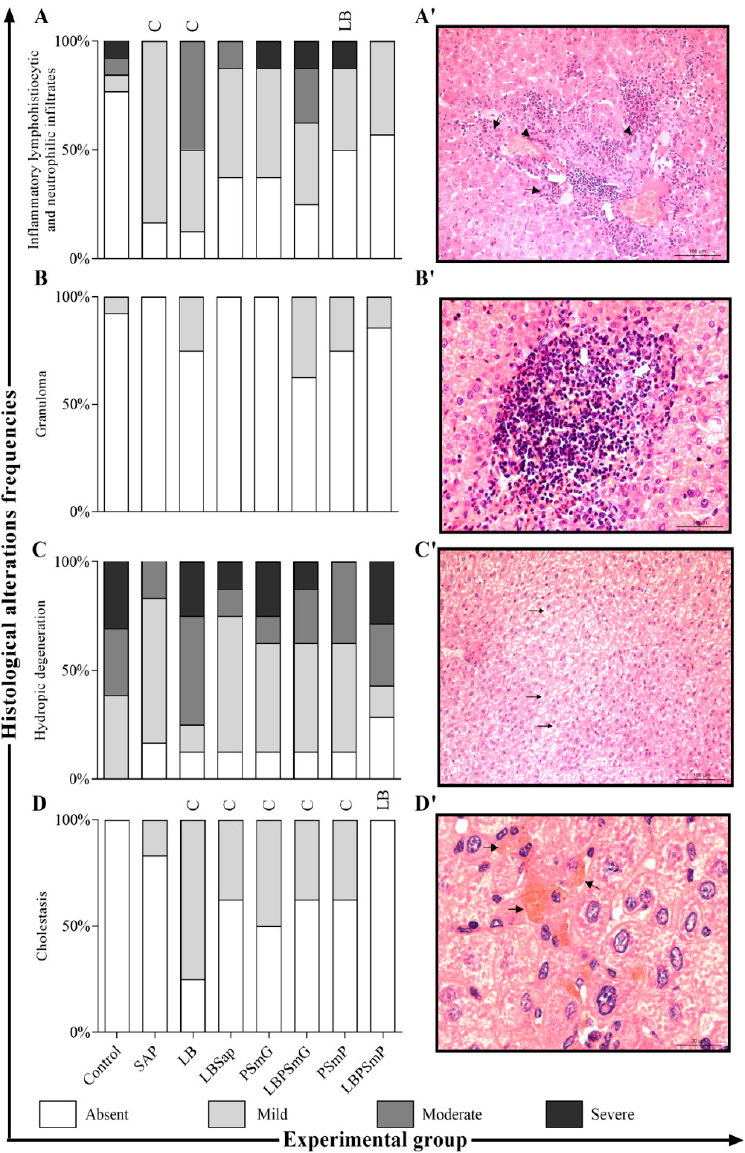
Figure 2. Histological changes in the liver after experimental L. infantum challenge in slides stained by Hematoxylin and Eosin. On the left: The x axis represents the frequency of each histological change ( A – D ) according to the immunization group (Control—C, Sap, LB, LBSap, PSmG, LBPSmG, PSmP, and LBPSmP) shown in the y axis. On the right: The photomicrographs refer to the main histological changes found in hamster livers after experimental challenge. ( A’ )—Inflammatory lymphohistiocytic and neutrophilic infiltrates: hepatitis characterized by inflammatory lymphohistiocytoplasmic (white arrows) and neutrophilic (head arrows) infiltrates with rare multinucleated giant cells (black arrows) (20× magnification); ( B’ )—Granuloma: lymphohysto-plasma-cell and neutrophilic hepatitis with some epithelioid macrophages (white arrows), characterizing hepatic micro-granulomas (40× magnification); ( C’ )—Hydropic degeneration: multifocal, discrete hydropic degeneration evidenced by the presence of intracytoplasmic vacuoles in hepatocytes (black arrow) (20× magnification); ( D’ )—Cholestasis: accumulation of intracytoplasmic pigment in hepatocytes (head arrow), compatible with bile pigment, multifocal, discrete, associated with moderate multifocal random lymphohistiocytic inflammatory infiltrate and hydropic, multifocal, discrete degeneration (100× magnification). Statistical differences ( p < 0.05, Mann–Whitney) between groups are indicated by acronyms in the correlated group(s).